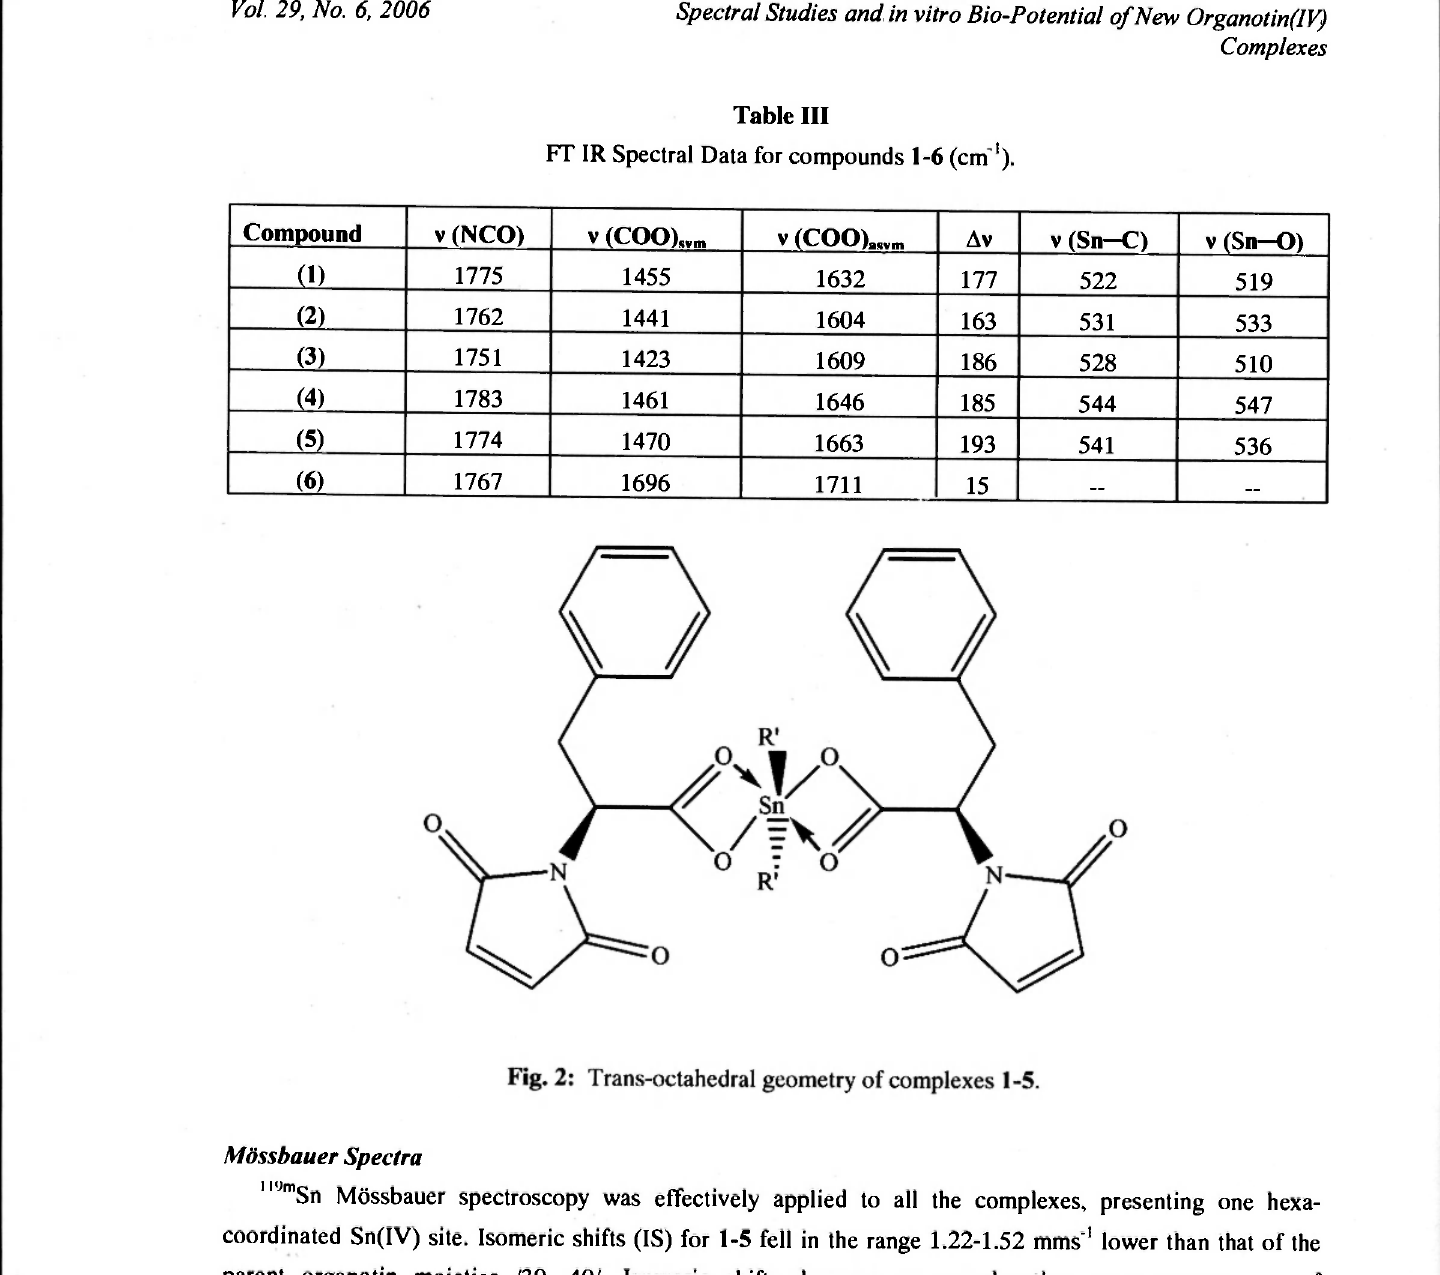
FT IR Spectral Data for compounds 1-6 (cm 1